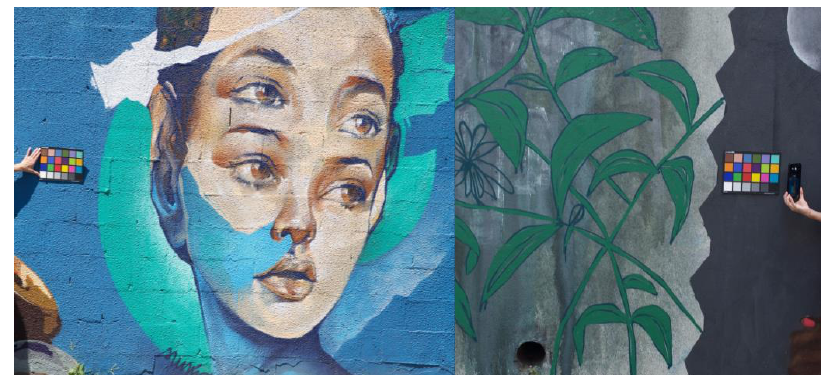
Figure 2. Illustration of the procedure of image acquisition. Left : acquiring the image with the X-Rite Macbeth ColorChecker Classic included in the field of view of the photo for colorimetric calibration and spatial scaling purposes. Right : acquisition of the illumination spectrum on the color chart with a portable spectro-colorimeter Everfine SPIC-200 for colorimetric calibration (the moment right before the photo).